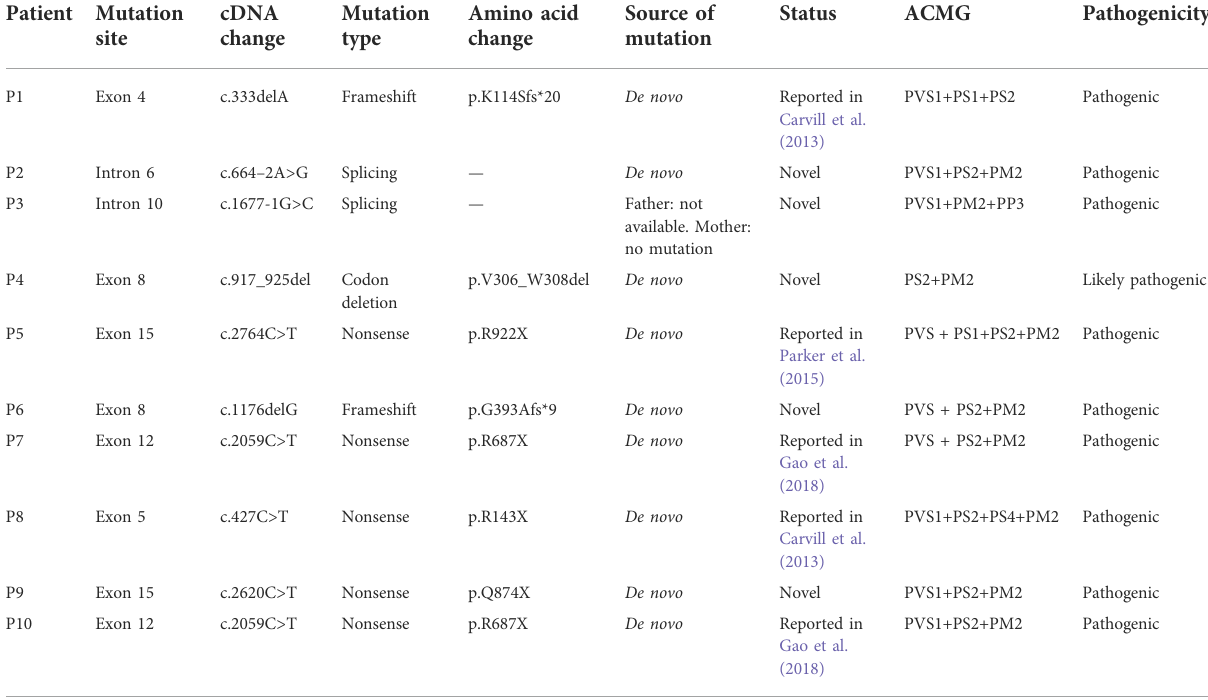
TABLE 2 Genetic information of 10 patients in our